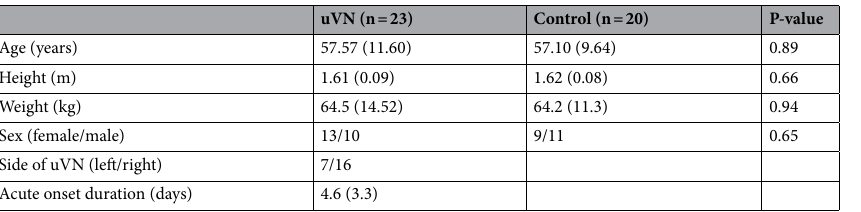
Table 1. Comparison of general characteristics between uVN and control groups. Comparisons between uVN and control were conducted using the t-test and chi-square test. Values are presented as mean (standard deviations). uVN unilateral vestibular